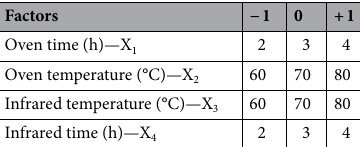
Table 2. Definition of the levels of the four variables studied in the combined drying of gelatin.